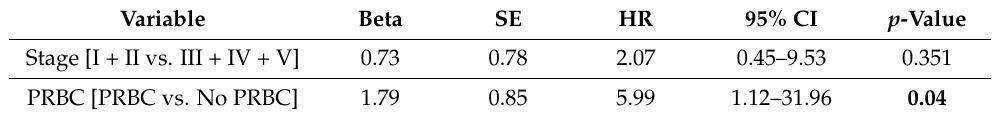
Table 5. Cox regression analysis. PRBC = packed red blood cells; RA = regional anesthesia; HR = hazard ratio; CI = confidence interval. Statistically significant results are shown in bold